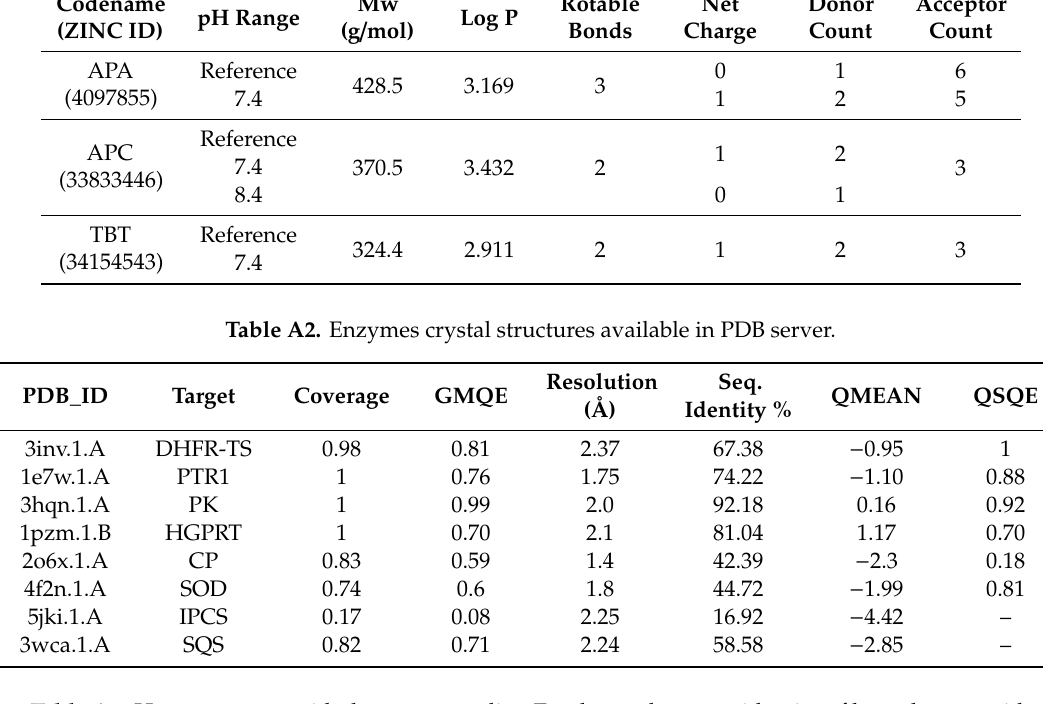
Table A3. Human targets with the corresponding E-value and percent identity of homologous with Leishmania. with low E-values; recommended threshold E < 0.001 [50].